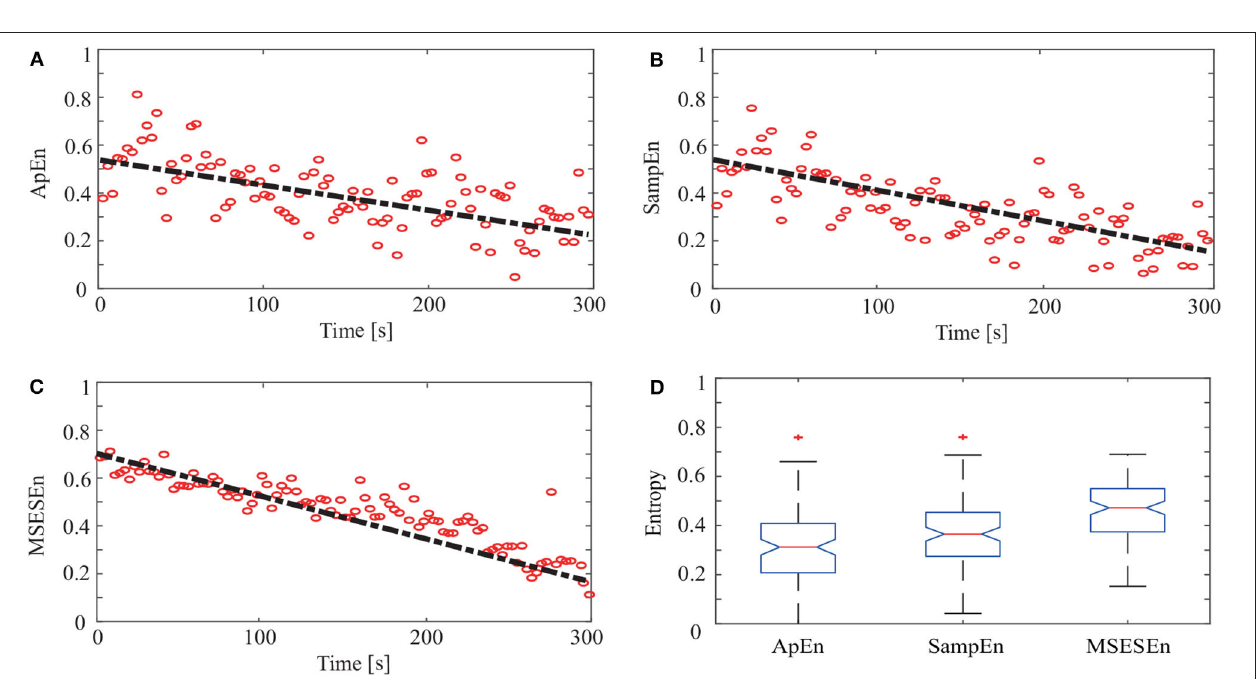
FIGURE 9 | ApEn, SampEn, and MSESEn of OCEEMD: (A) ApEn (gradient: − 0.0034), (B) SampEn (gradient: − 0.0038), (C) MSESEn (gradient: − 0.0051), and (D) box diagram.